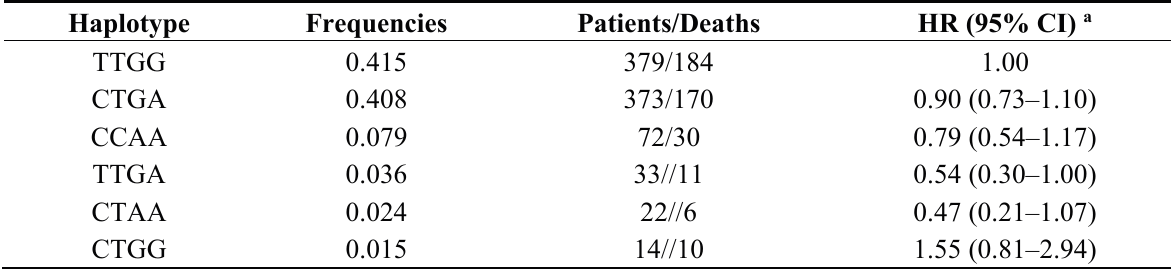
Table 3. Haplotype analyses of NR5A2 rs3790843 and rs3790844